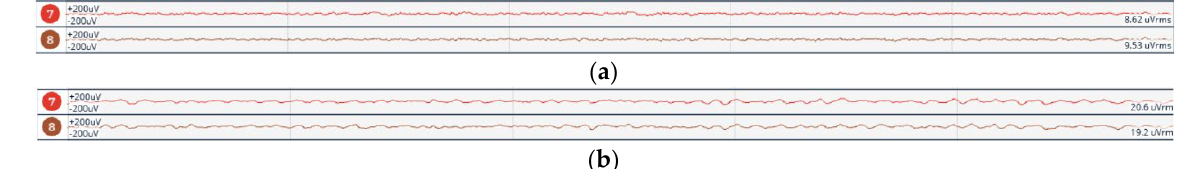
Figure 10. Response of occipital region during eye open and closed state. ( a ) Opened eyes; ( b ) closed eyes.